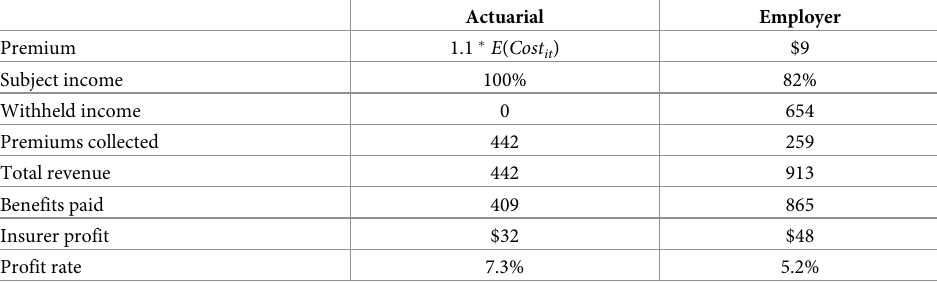
Table 2. Treatment details.